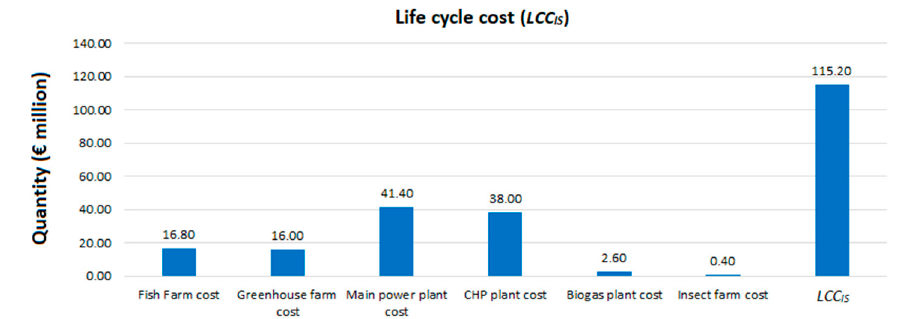
Figure 5. Life cycle cost of products in symbiotic environment in Sodankylä.